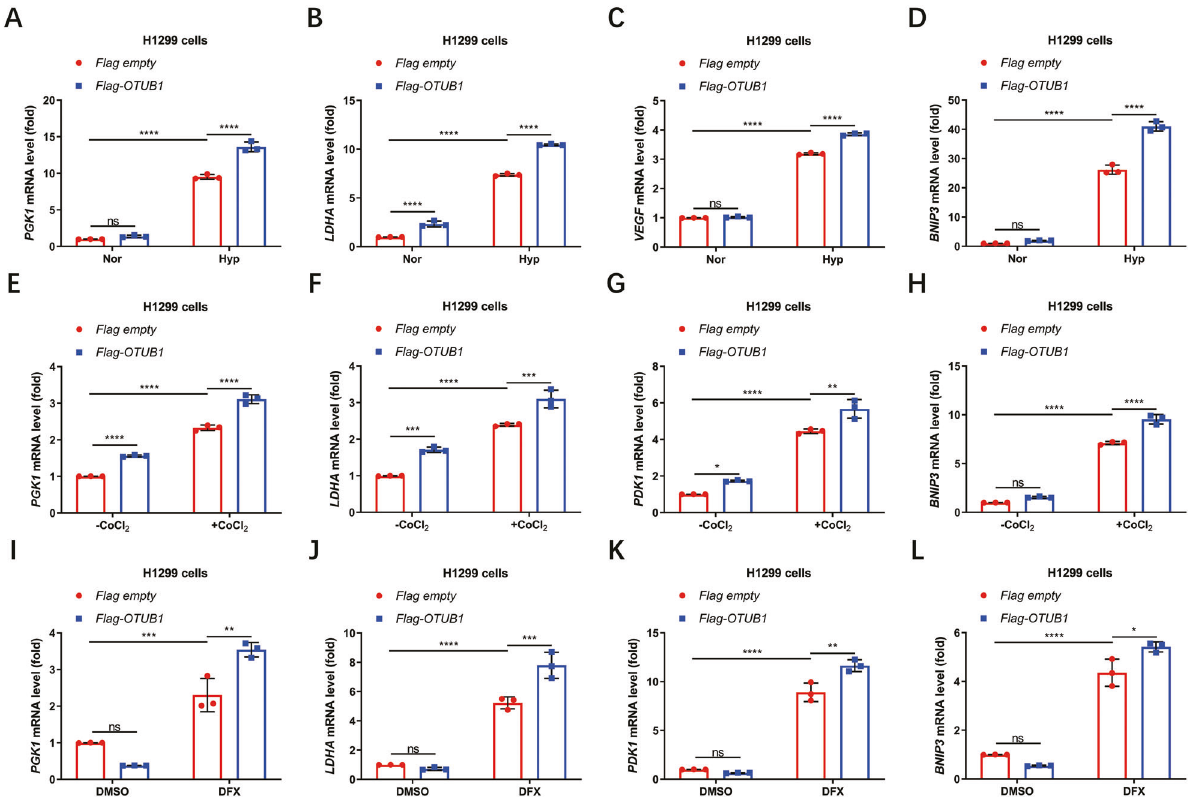
Fig. 1 OTUB1 augments hypoxia signaling. A – D qPCR analysis of PGK1 ( A ), LDHA ( B ), VEGF ( C ), and BNIP3 ( D ) mRNA in H1299 cells transfected with or without Flag-OTUB1 and cultured under normoxia (21% O 2 ) or hypoxia (1% O 2 ) for 24 h. Flag empty vector was used as a control. E – H qPCR analysis of PGK1 ( E ), LDHA ( F ), PDK1 ( G ), and BNIP3 ( H ) mRNA in H1299 cells transfected with or without Flag-OTUB1 and treated with or without CoCl 2 (200 μ M) for 8 h. Flag empty vector was used as a control. I – L qPCR analysis of PGK1 ( I ), LDHA ( J ), PDK1 ( K ), and BNIP3 ( L ) mRNA in H1299 cells transfected with or without Flag-OTUB1 and treated with DFX (150 μ M) or DMSO as a control for 8 h. Flag empty vector was used as a control. Two-way ANOVA analysis; Data show mean ± SD; Tukey ’ s multiple comparisons test; ns, not signi fi cant, *Adjusted p < 0.05, **Adjusted p < 0.01, ***Adjusted p < 0.001, ****Adjusted p < 0.0001; Data from 3 independent